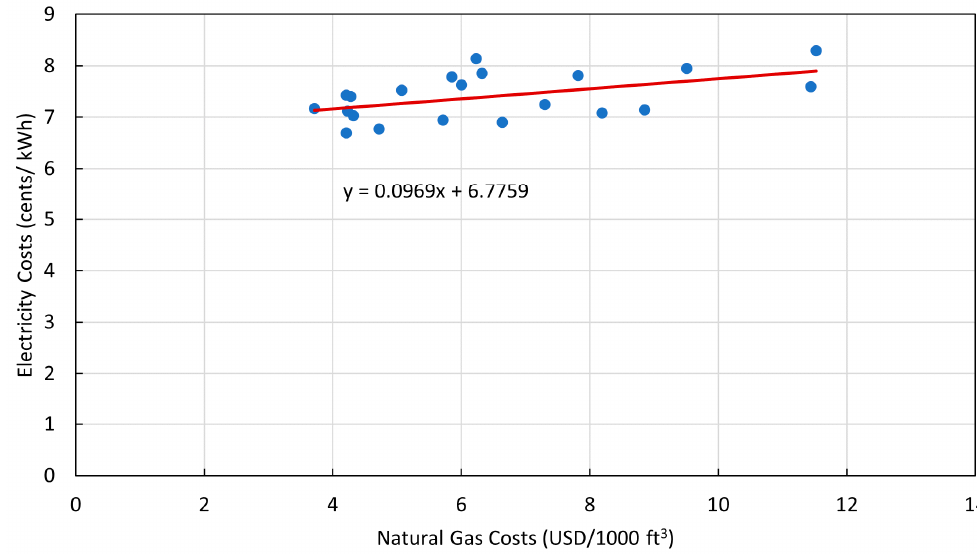
Figure A2. Linear relationship between electricity and natural gas cost. Linear relationship between electricity and natural gas cost. This relationship was used to determine equation 32. Information was obtained from the United States EIA and average costs were normalized to January 2019 US currency [40,42]. Figure produced using Microsoft Excel. Table A1. Model variable inputs: Operations.